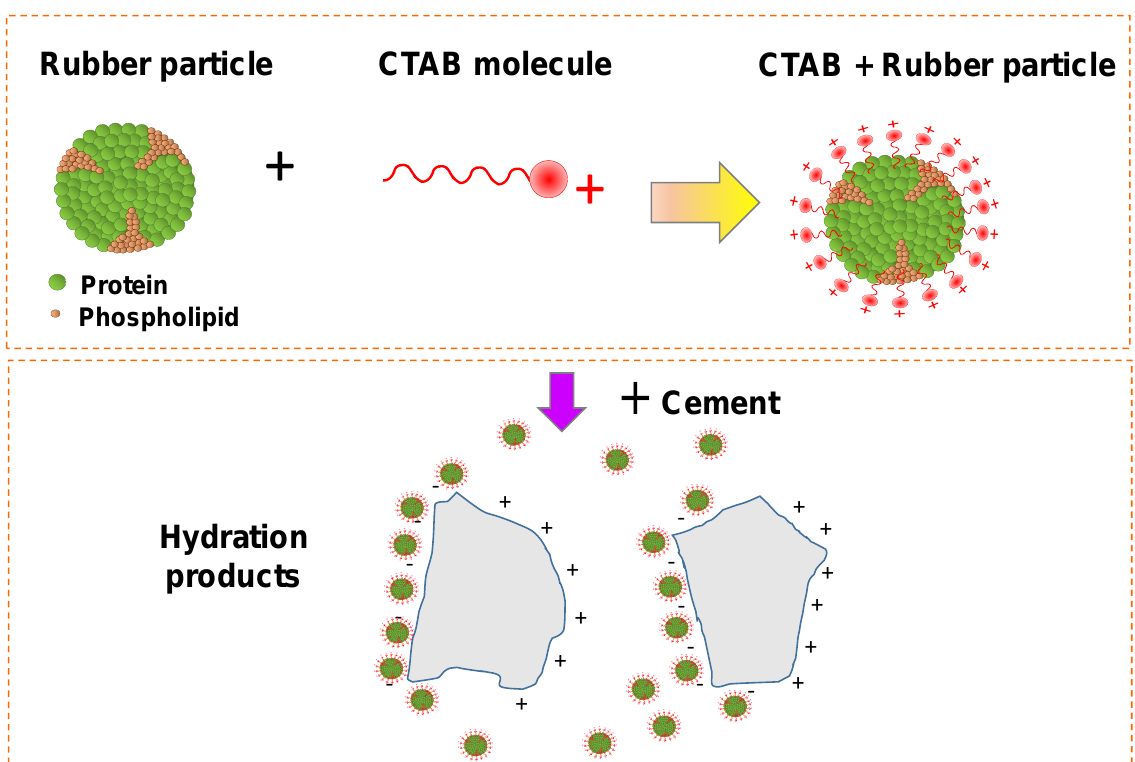
Figure 10. Schematic of the possible mechanism of the interaction between the NL – CTAB – PC ma- trix.